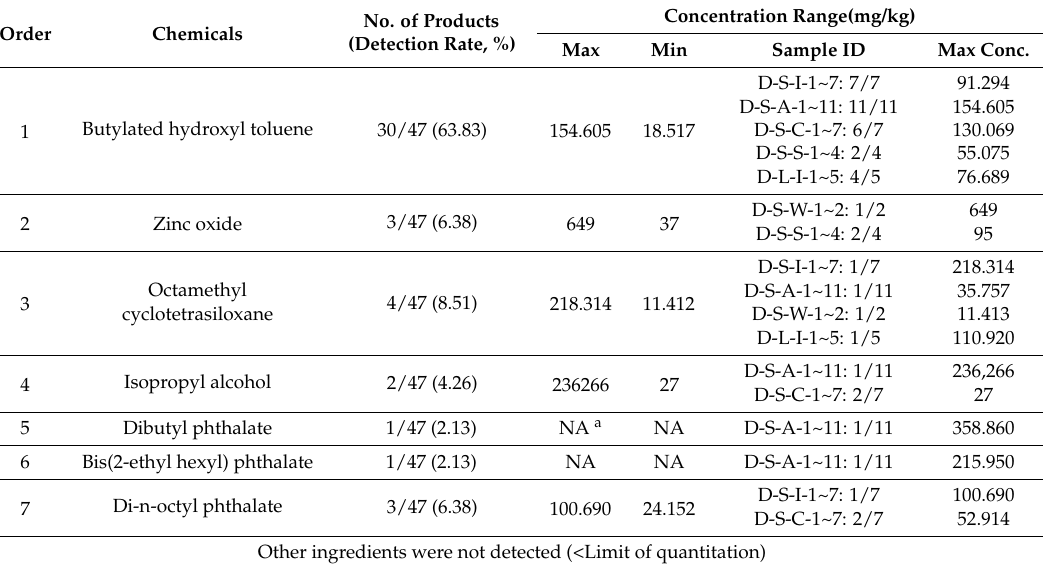
Table 7. Results of an analysis of 17 target ingredients from deodorizing